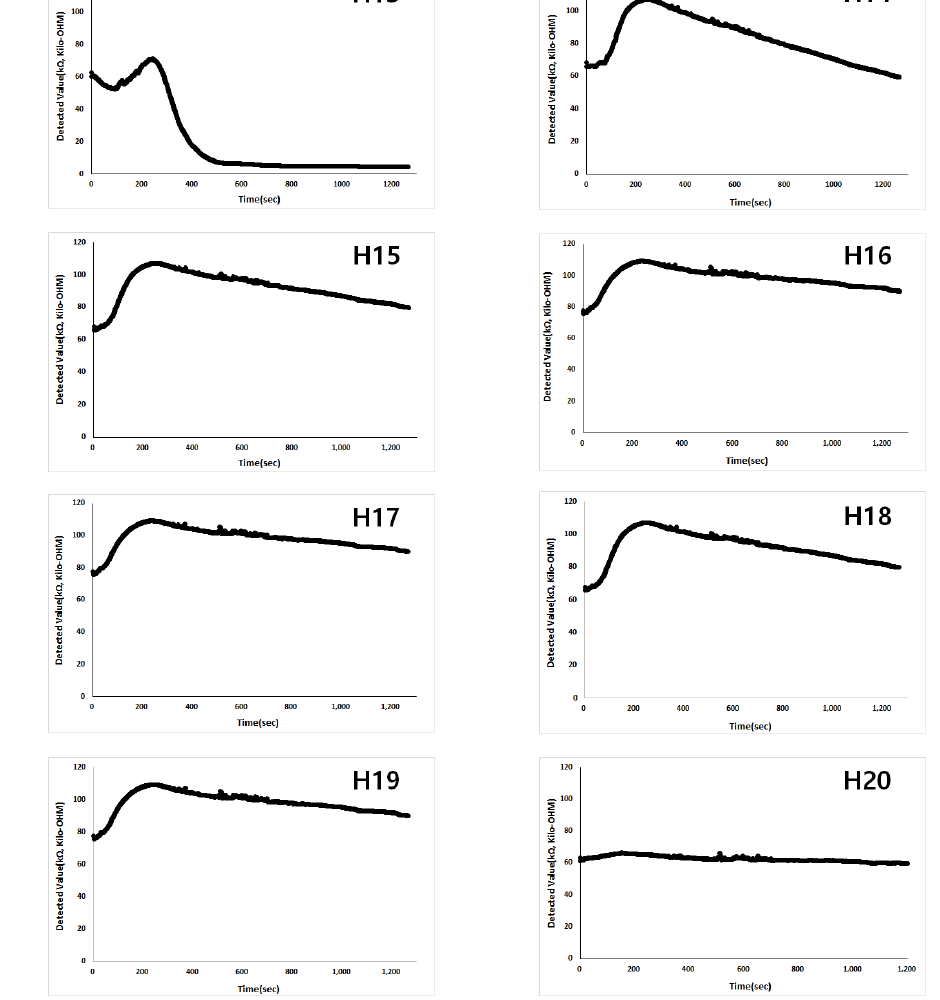
Figure 9. Variation of H13 – H20 CdS photoresistors in sludge sedimentation detecting.